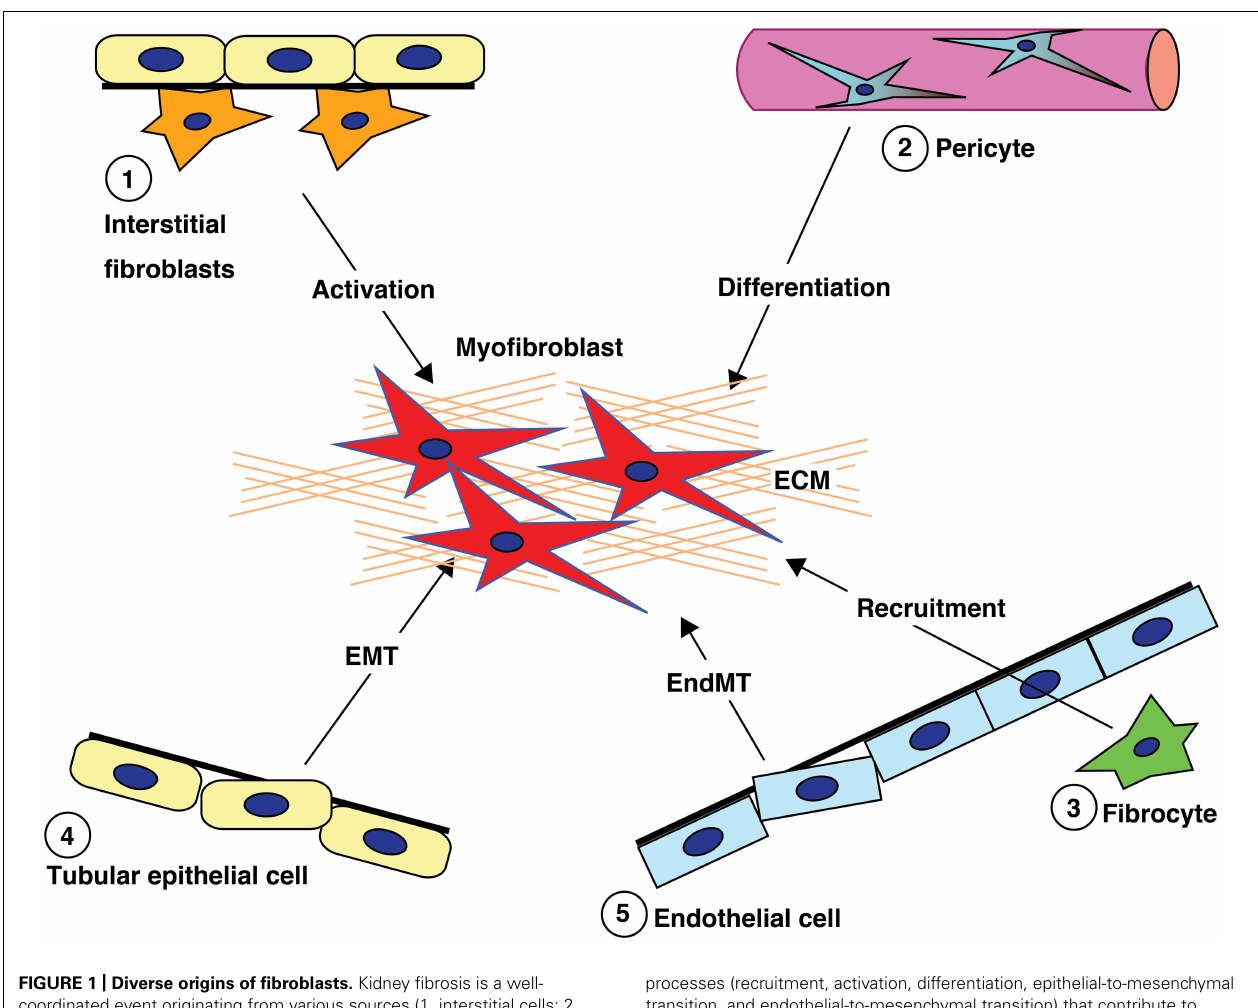
processes (recruitment, activation, differentiation, epithelial-to-mesenchymal transition, and endothelial-to-mesenchymal transition) that contribute to myofibroblast